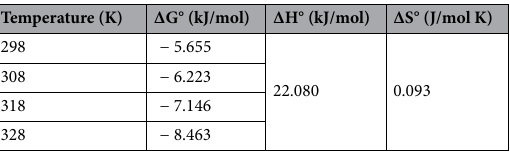
Table 4. Thermodynamic coefficients for adsorption CR onto K@AM-CTS composite beads.